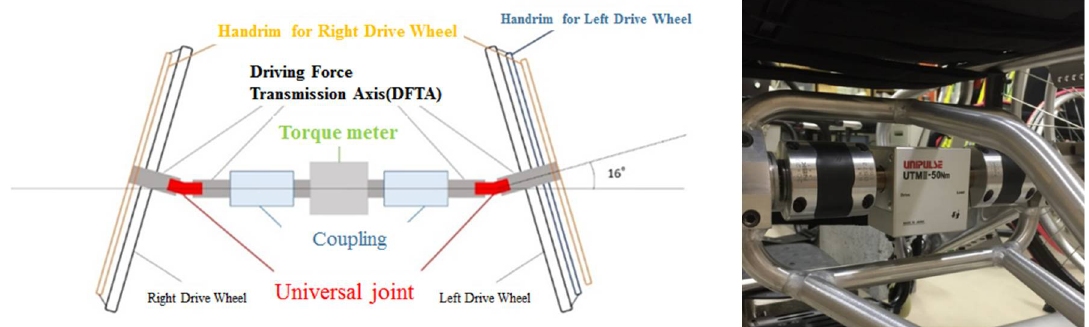
Figure 4. The outline of the system to measure the torque in the DFTA.